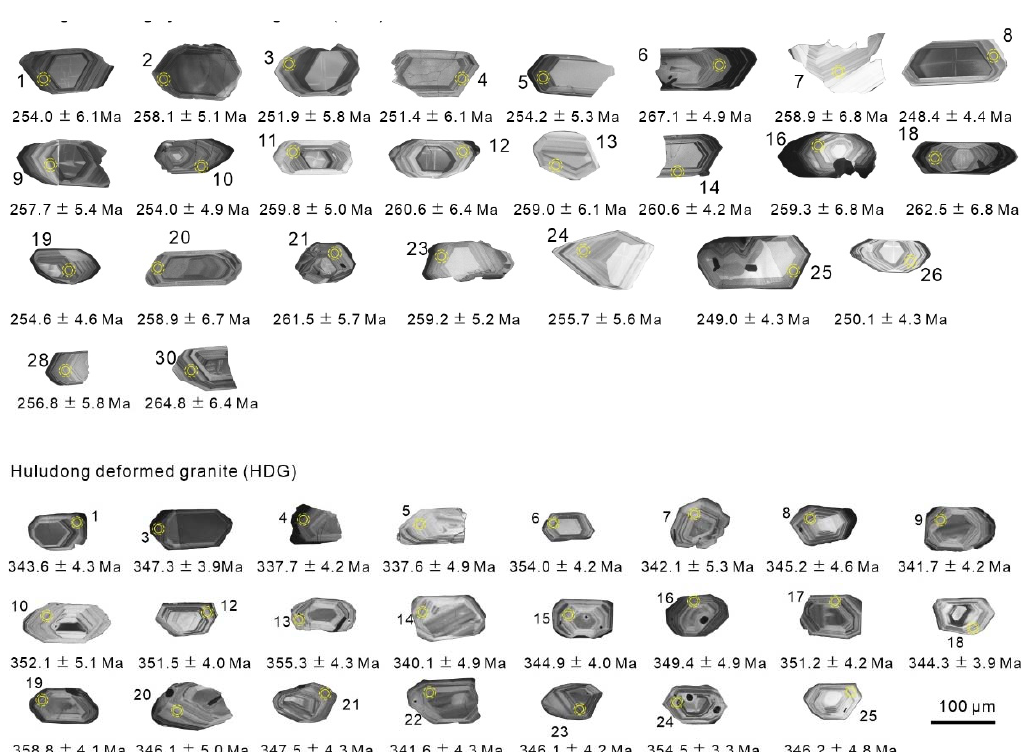
Figure 3. Cathodoluminescence (CL) images of representative zircons from the HSG and HDG.